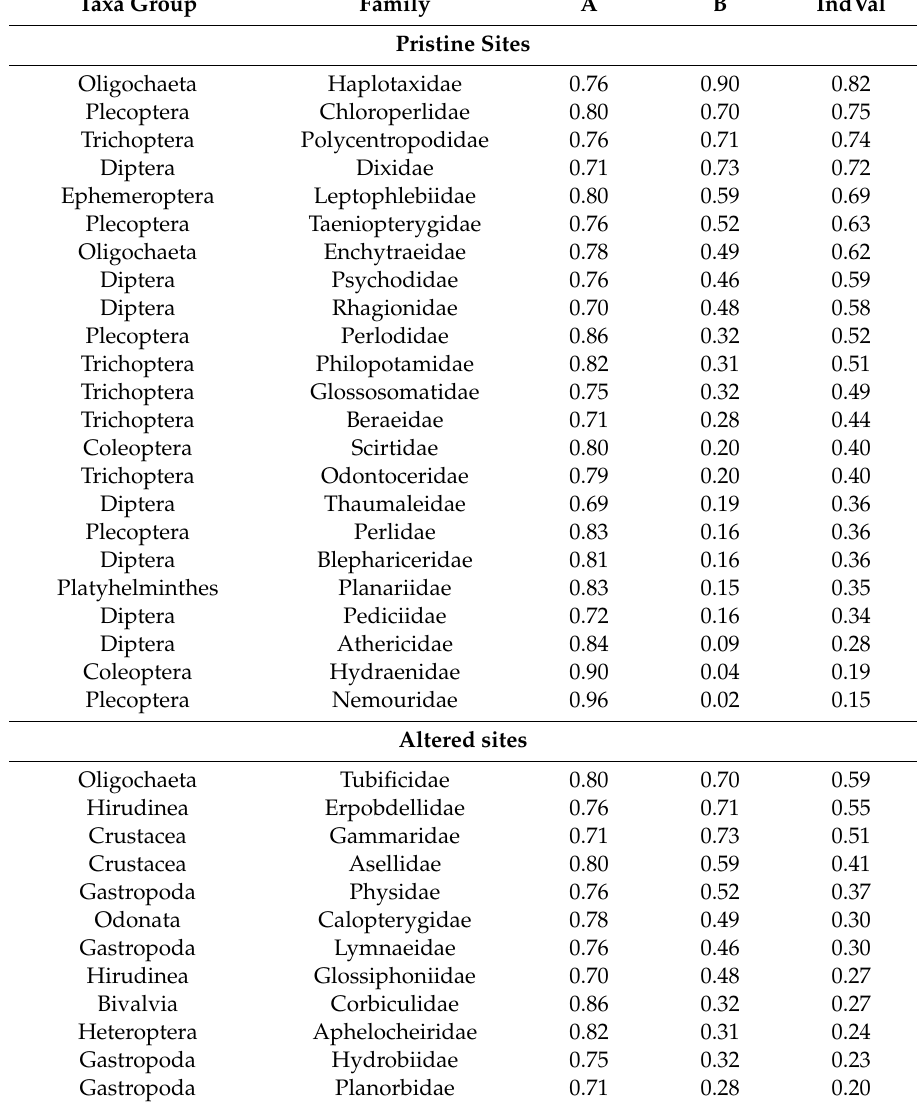
Table 1. Results of the IndVal analysis for Pristine and Altered sites. A represent the probability that the surveyed site belongs to the target site group given the fact that the family has been found, whereas B represent the probability of finding the family in sites belonging to the site group. All the reported associations were significant after 999 permutation at alpha =